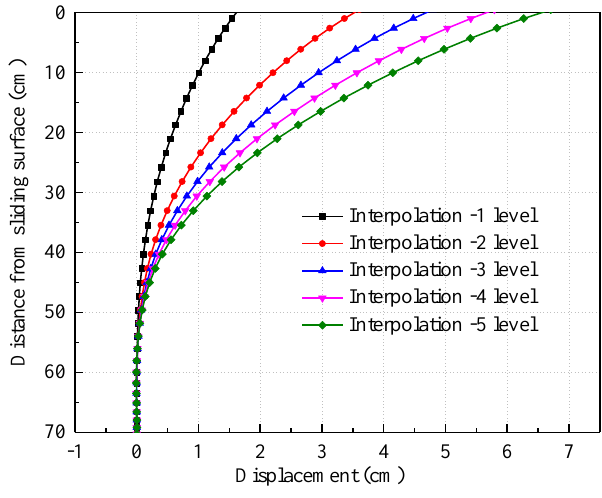
Figure 13. Pile displacement distribution map.